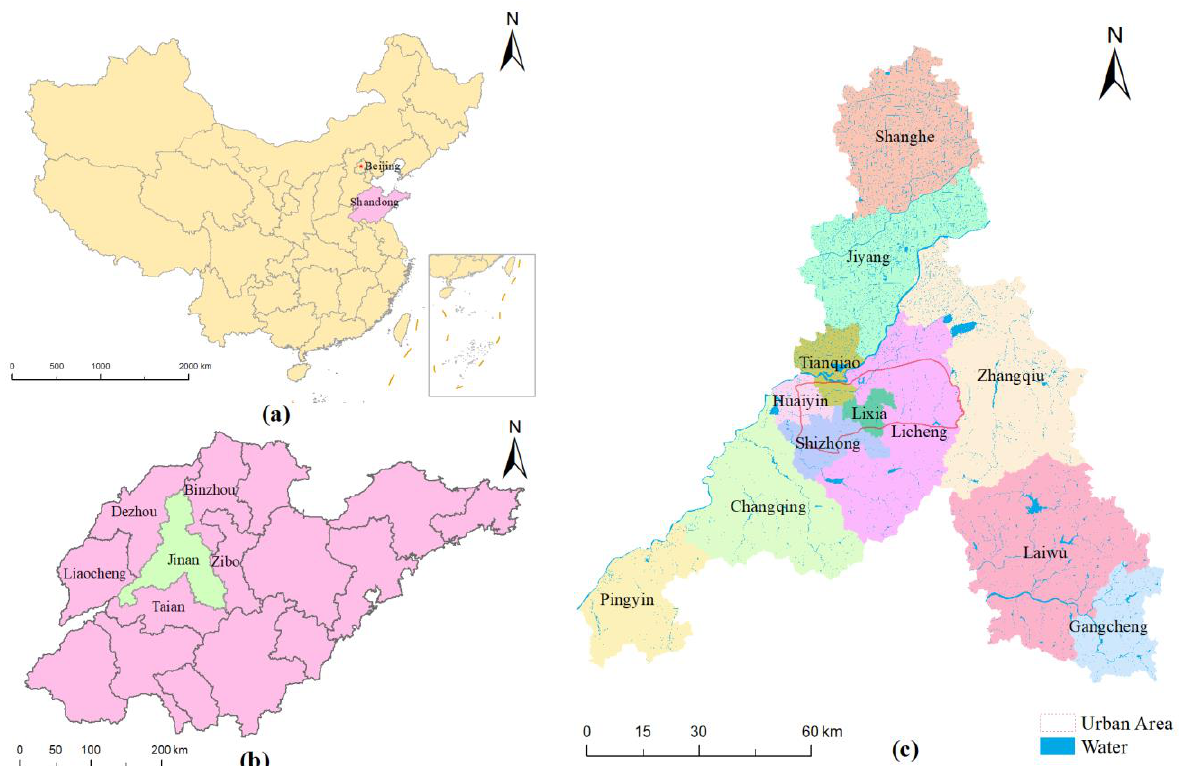
Figure 1. Geographical location map of the study area:( a ) location of Shandong Province in China; ( b ) location of Jinan City in Shandong Province; ( c ) location of districts and counties in Jinan.